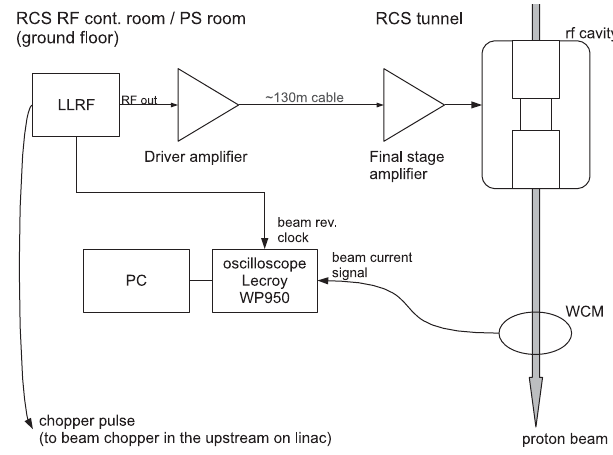
FIG. 2. Beam test setup. For simplicity, only one of the ten cavities is